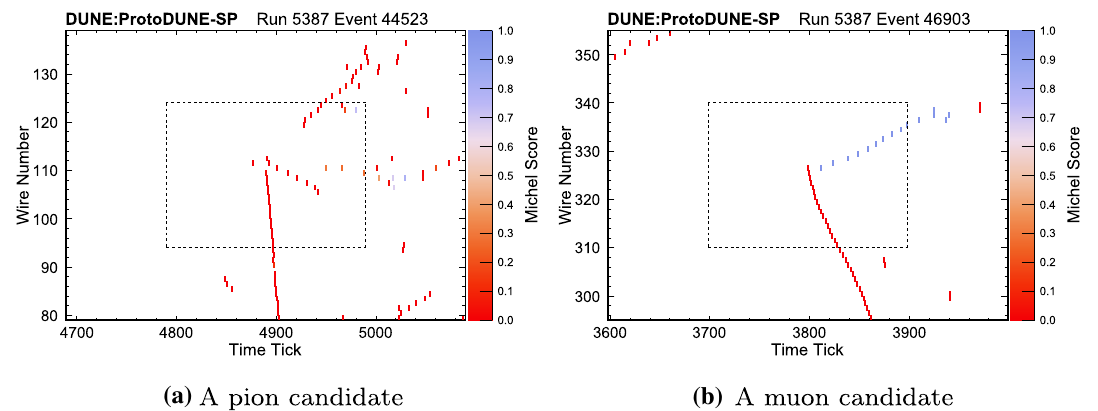
Fig. 13 CNN Michel score for reconstructed primary beam particles and secondary particles in a reconstructed pion (left) and muon (right) particle. Each coloured pixel shows the peak time and wire number of a Fig. 14 CNN Michel score for the daughter hits in the 30 wires × 200 ticks window centred around the reconstructed track end point of the pion (left) and muon (right) particles